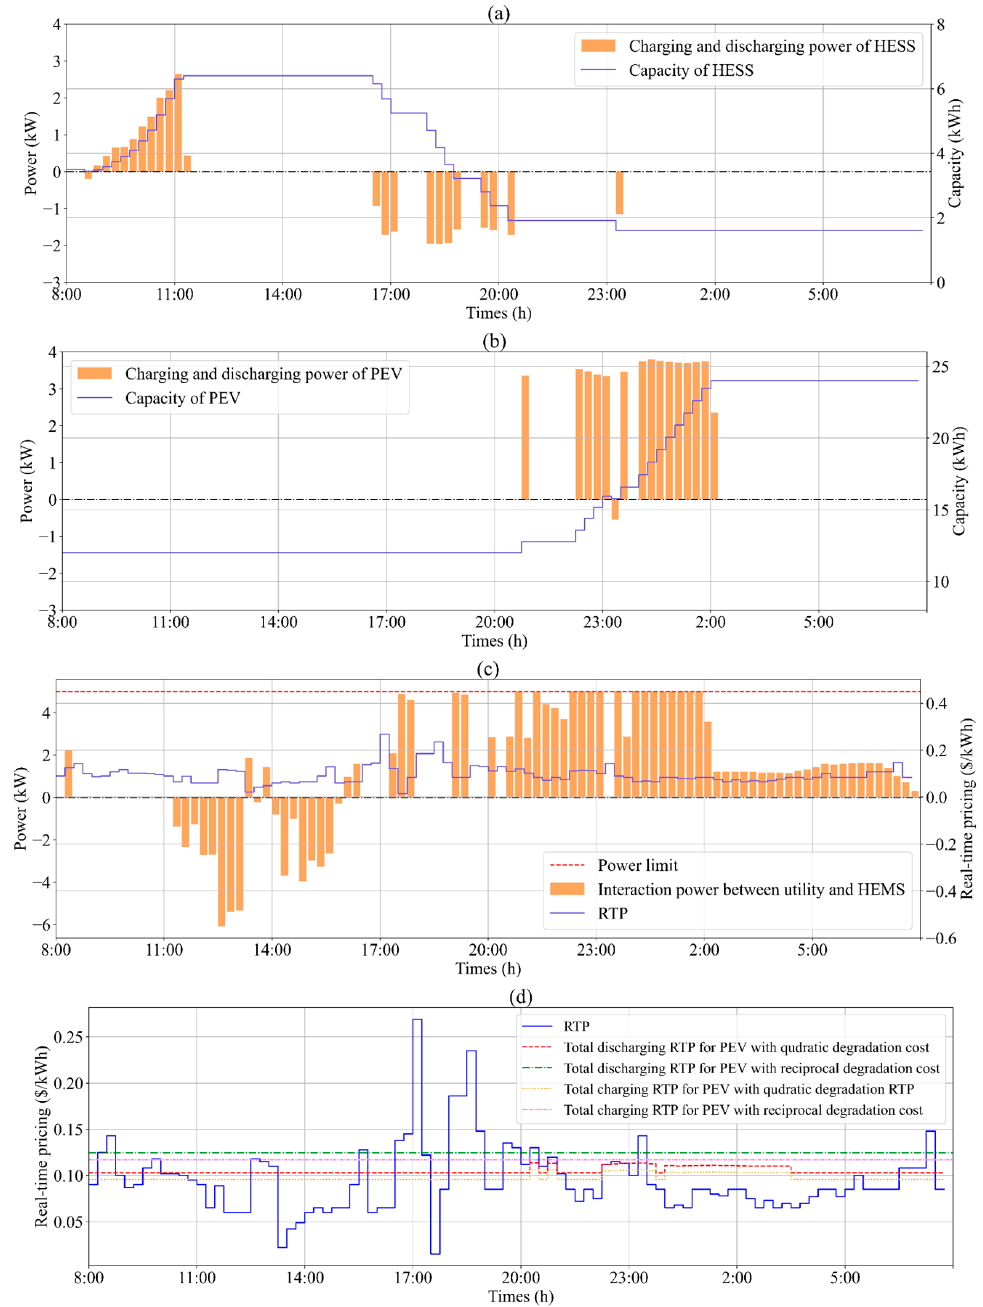
Figure 15. Load profiles for ( a ) HESS in HESS2H mode, ( b ) PEV in V2H mode, ( c ) H-MG without mode segmentation strategy, and ( d ) RTP comparison of PEV considering degradation cost.